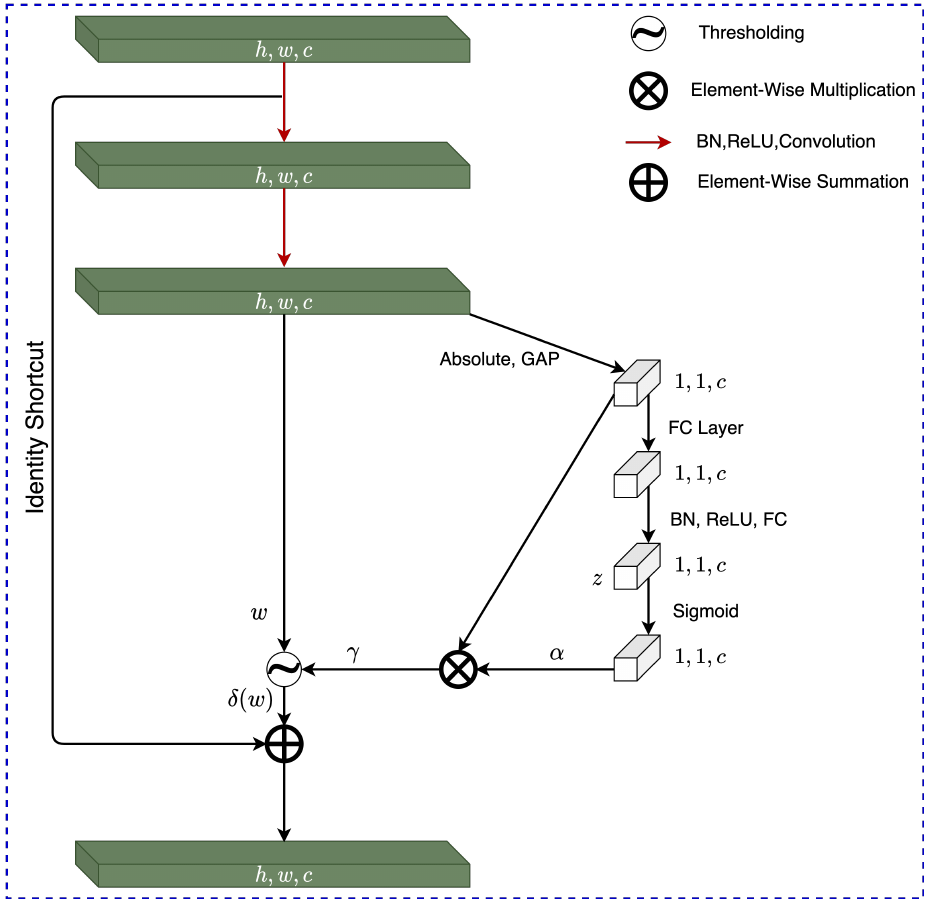
Figure 5. Residual Shrinkage Building Unit-1